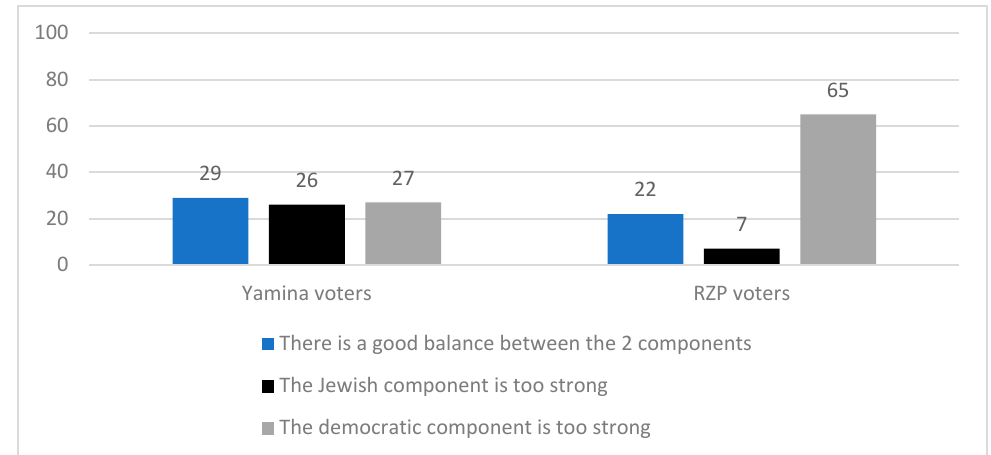
Figure 19. Israel is defined as a Jewish and democratic state. Do you feel there is a good balance today between the Jewish and the democratic components? (by voting in 2021, %) Source: Israeli Democracy Index, 2021.